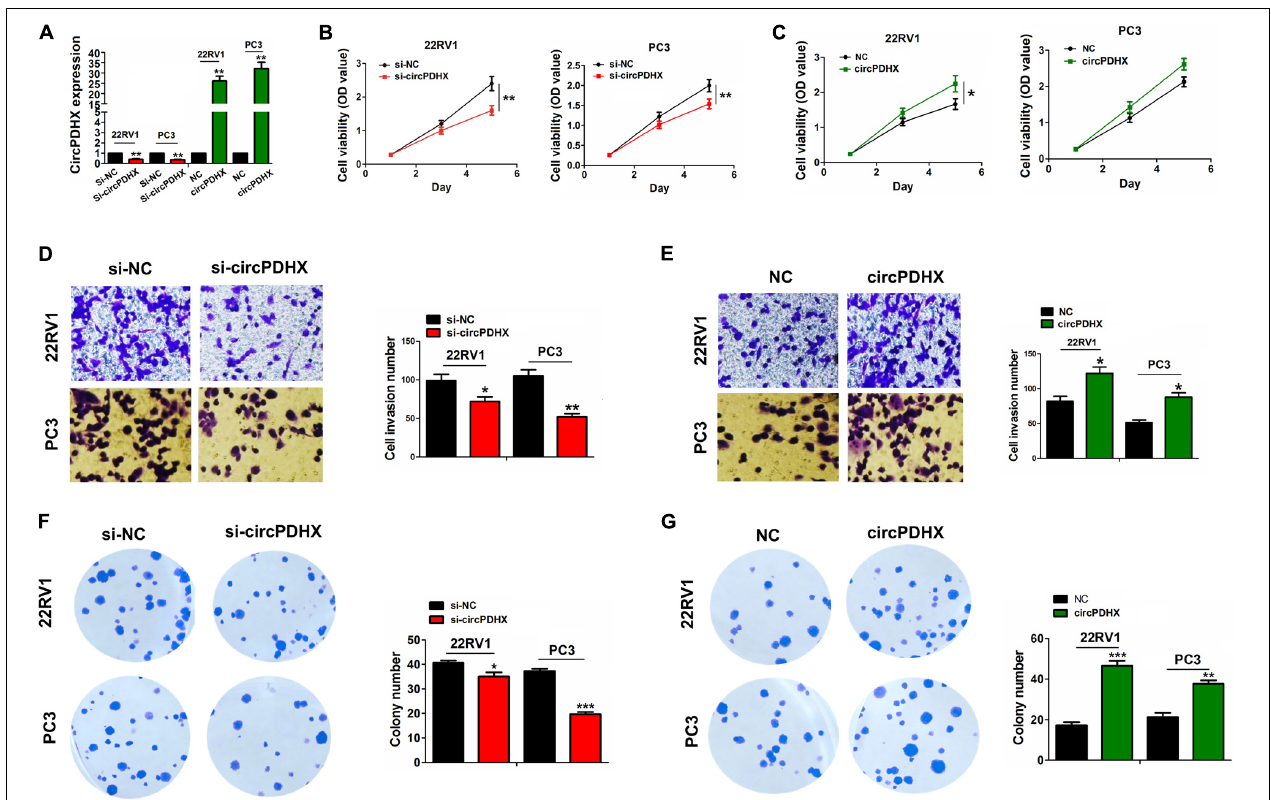
FIGURE 3 | circPDHX promoted prostate cancer (PCa) cell proliferation, colony formation, and cell invasion. (A) Quantitative real-time PCR (qRT-PCR) analysis of the expression levels of circPDHX after transfection with si-circPDHX or circPDHX plasmids in 22RV1 and PC3 cell lines. (B,C) 3-(4,5-Dimethylthiazol-2-yl)- 2,5-diphenyltetrazolium bromide (MTT) analysis of the cell proliferation after transfection with si-circPDHX or circPDHX plasmids in 22RV1 and PC3 cell lines. (D,E) Transwell analysis of cell invasion after transfection with si-circPDHX or circPDHX plasmids in 22RV1 and PC3 cells. (F,G) Colony formation analysis of the cell colony formation abilities after transfection with si-circPDHX or circPDHX plasmids in 22RV1 and PC3 cell lines. Data shown are the mean ± SEM of three experiments. * P < 0.05; ** P <